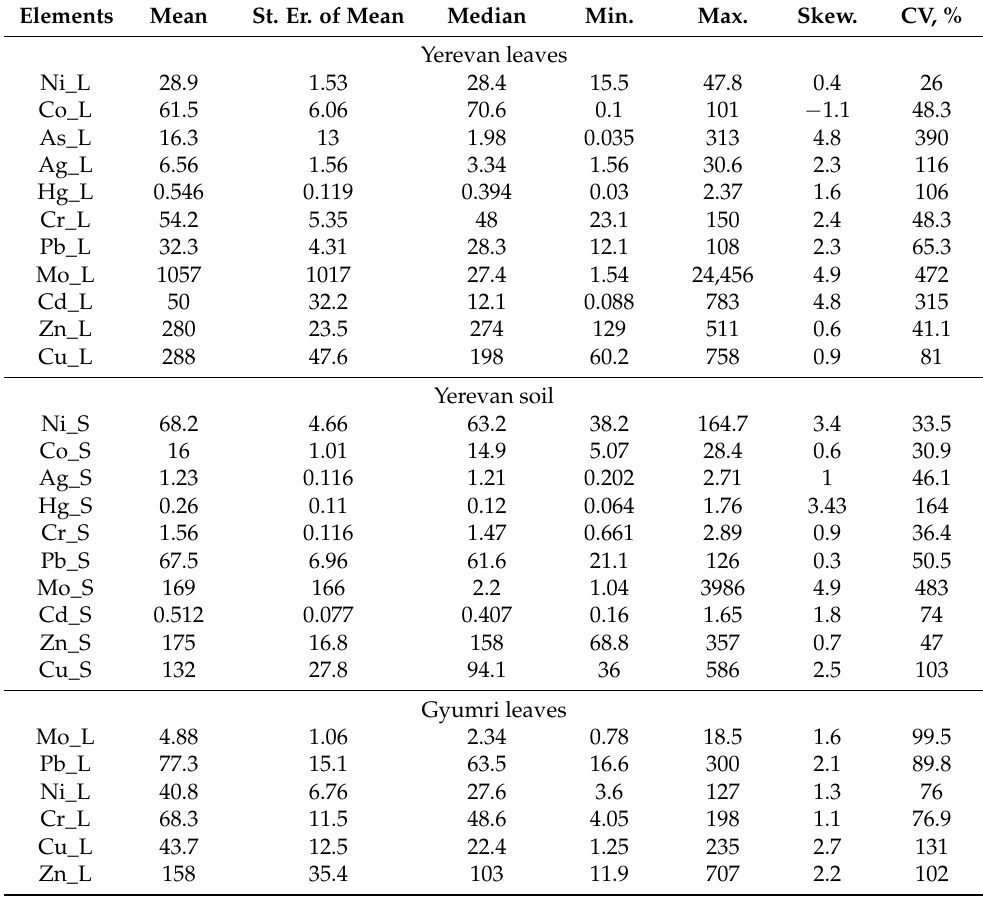
Table 1. The descriptive statistical parameters of the studied chemical elements (mg/kg) and the coefficient of variation (CV, %) in Yerevan and Gyumri. Elements Mean St. Er. of